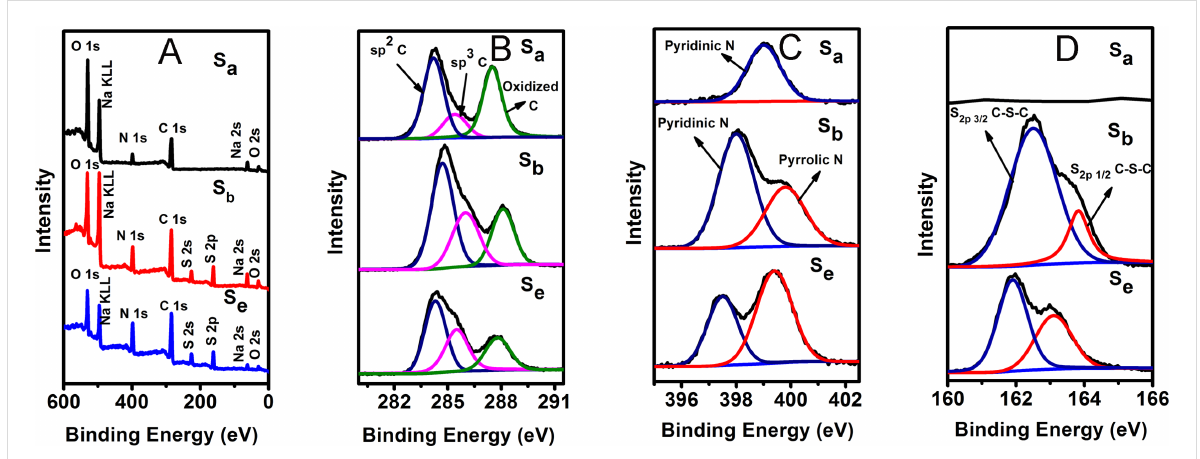
Figure 4: XPS spectra of S a , S b, and S e . (A) full scan, (B) high-resolution C 1s XPS spectra, (C) high-resolution N 1s XPS spectra, and (D) high-reso- lution S 2p XPS spectra.